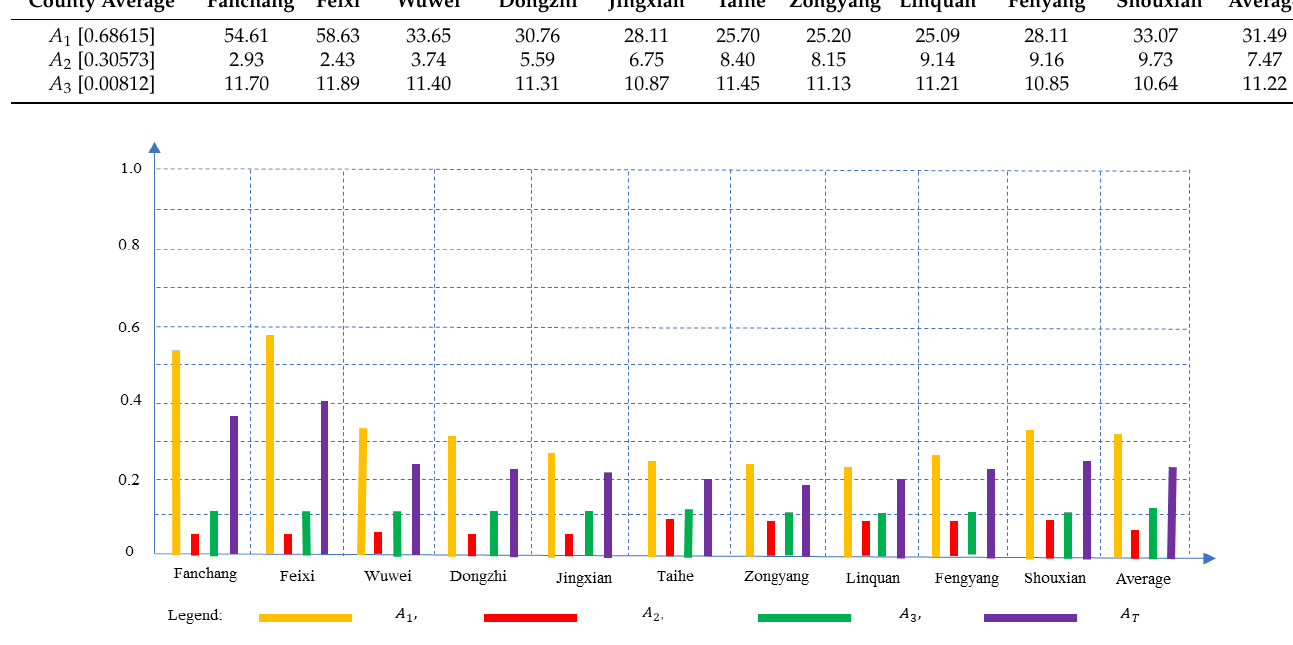
Figure 3. Progress of water pollution control in 10 sample counties in 2020.